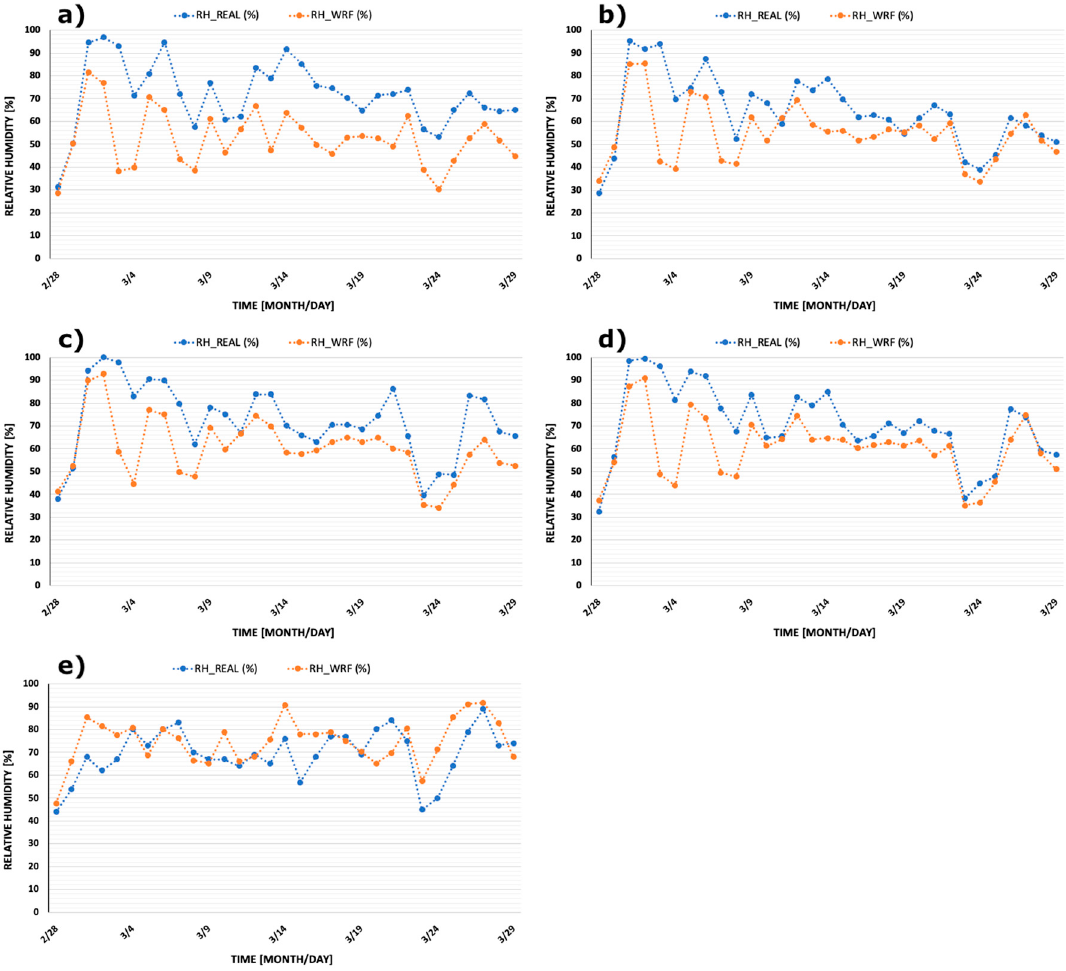
Figure 3. Comparisons between daily mean relative humidity measured at selected province monitoring stations (‘RH_REAL’) and the related average over each province obtained through the WRF model (‘RH_WRF’). Provinces are: ( a ) Bergamo, ( b ) Brescia, ( c ) Mantova, ( d ) Cremona, and ( e ) Pesaro Urbino.